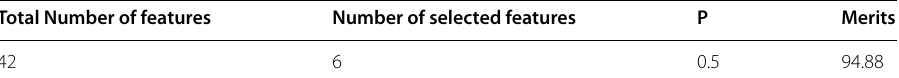
Table 9 Number of selected features by proposed method on P-dataset Total Number of features